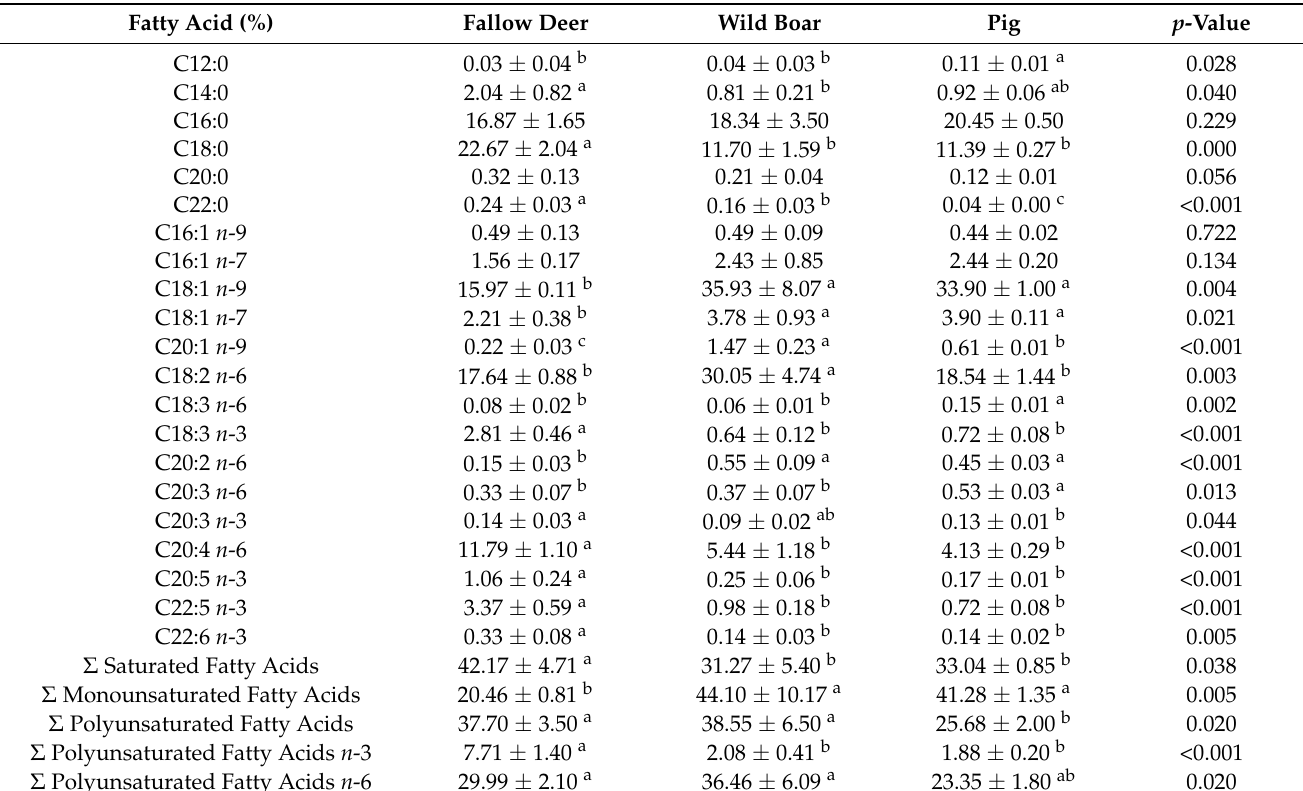
Table 3. The results of the fatty acid profile determination of the shoulder meat samples (%/total fatty acid; mean ±